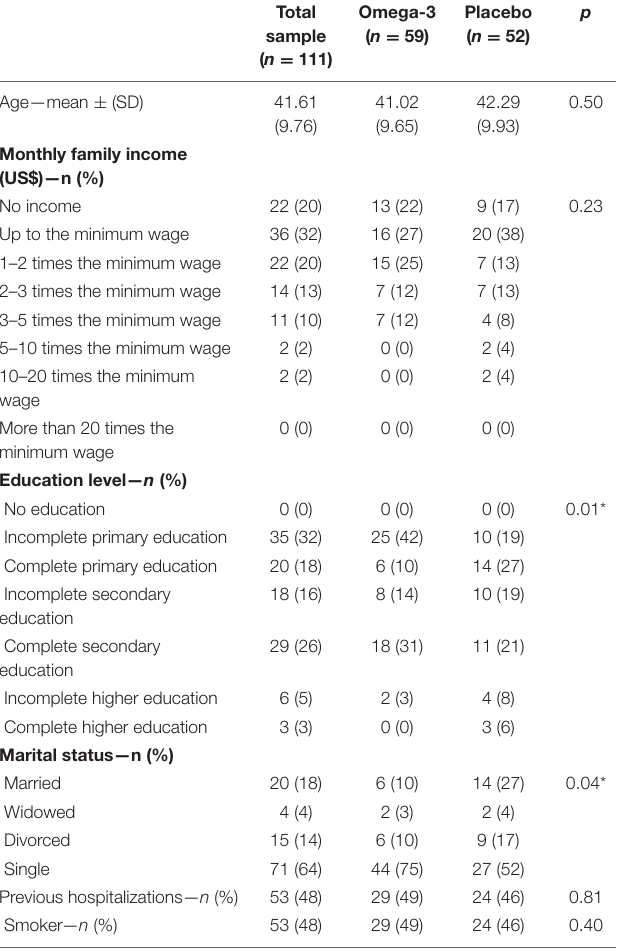
TABLE 1 | Sociodemographic characteristics at baseline for the total sample and by experimental